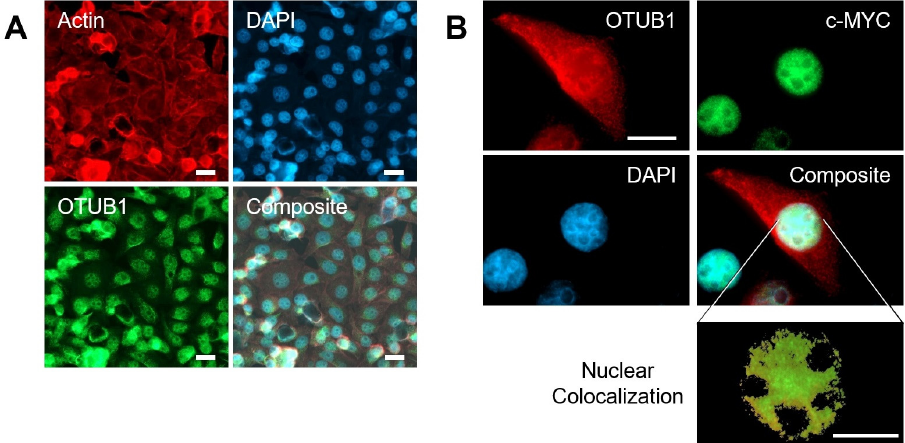
Figure 6. OTUB1 and c-MYC colocalize. ( A ) Immunofluorescence of endogenous OTUB1 confirmed nuclear expression of the deubiquitinase in HeLa cells. Cells were stained for Actin, OTUB1, and the nuclear marker DAPI. Magnification 50×, bar represents 20 μ m. ( B ) Colocalization experiment with HeLa cells transfected with FLAG-tagged OTUB1. The tag allowed the simultaneous detection of OTUB1 with the anti-FLAG antibody in combination with an endogenous c-MYC antibody to visualize both proteins. Inset showing a 100× magnification of a single z-stack of the nucleus depicts c-MYC signal in green and OTUB1 in red. Both proteins robustly colocalized in this compartment. Bar represents 10 μ m.